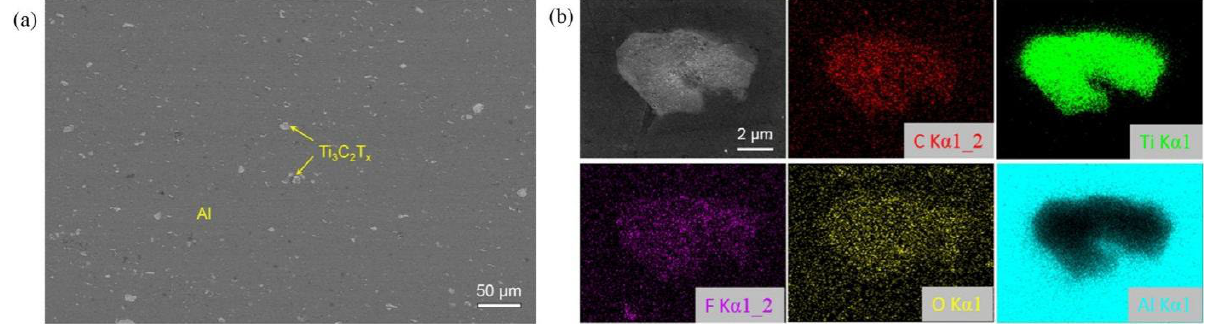
Figure 6. ( a ) Backscattered SEM micrograph of the polished surface of 3 wt.% Ti 3 C 2 T x /Al composite.